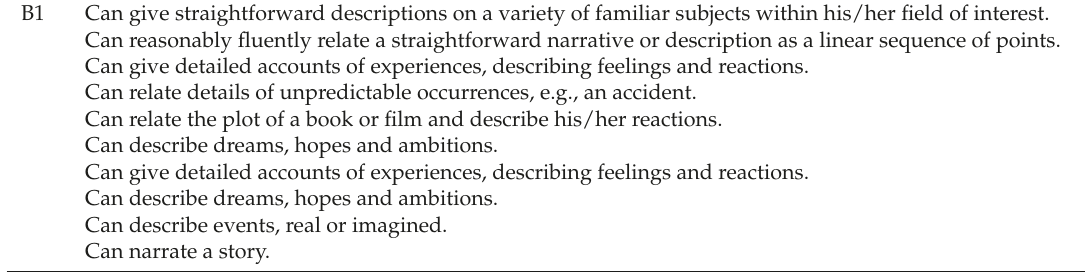
Table 1. Common European Framework of References for Languages (CEFR) B1 descriptor: Sustained Monologue (describing experience), Council of Europe [7] (p.